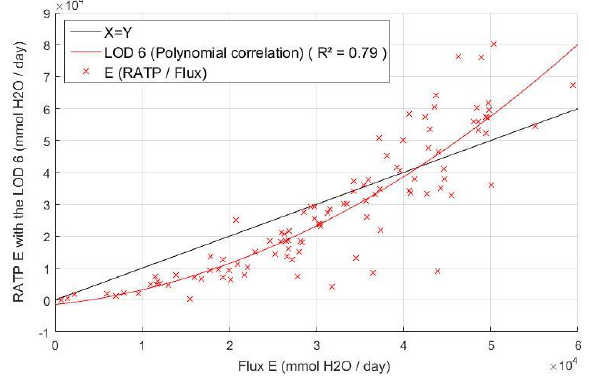
Figure 10. Comparison of the evapotranspiration (E) estimated by RATP model, with the flux of sap